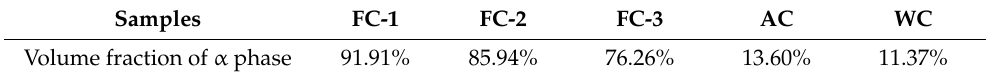
Table 2. The volume fraction of α phase in Zr-4Hf-3Nb (wt%) alloy at different cooling rate. Samples